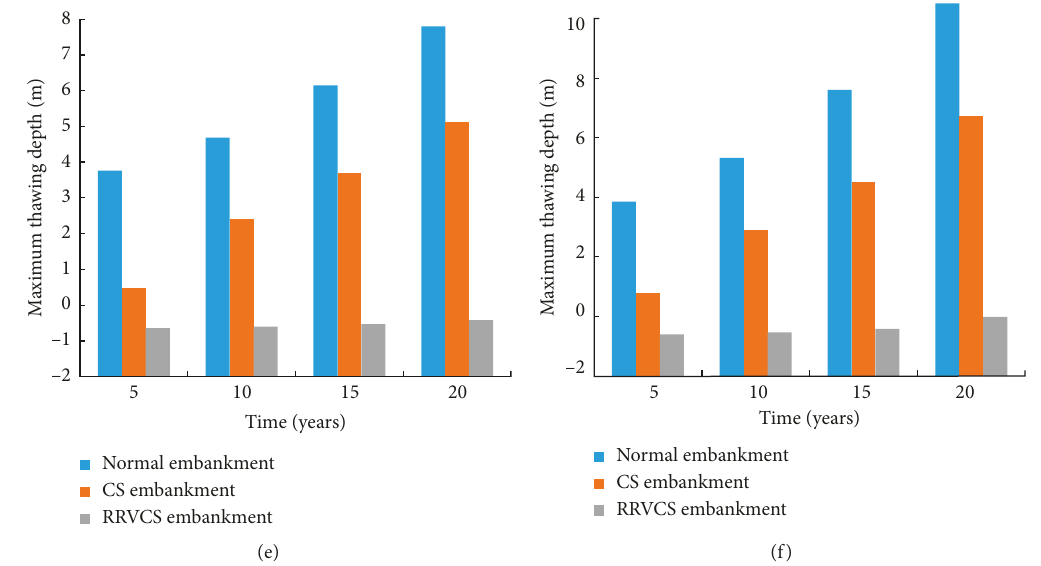
Figure 12: The maximum thawing depth versus service time for embankments with different widths: (a) 10m, (b) 18m, (c) 26m, (d) 34m, (e) 42m, and (f) 50